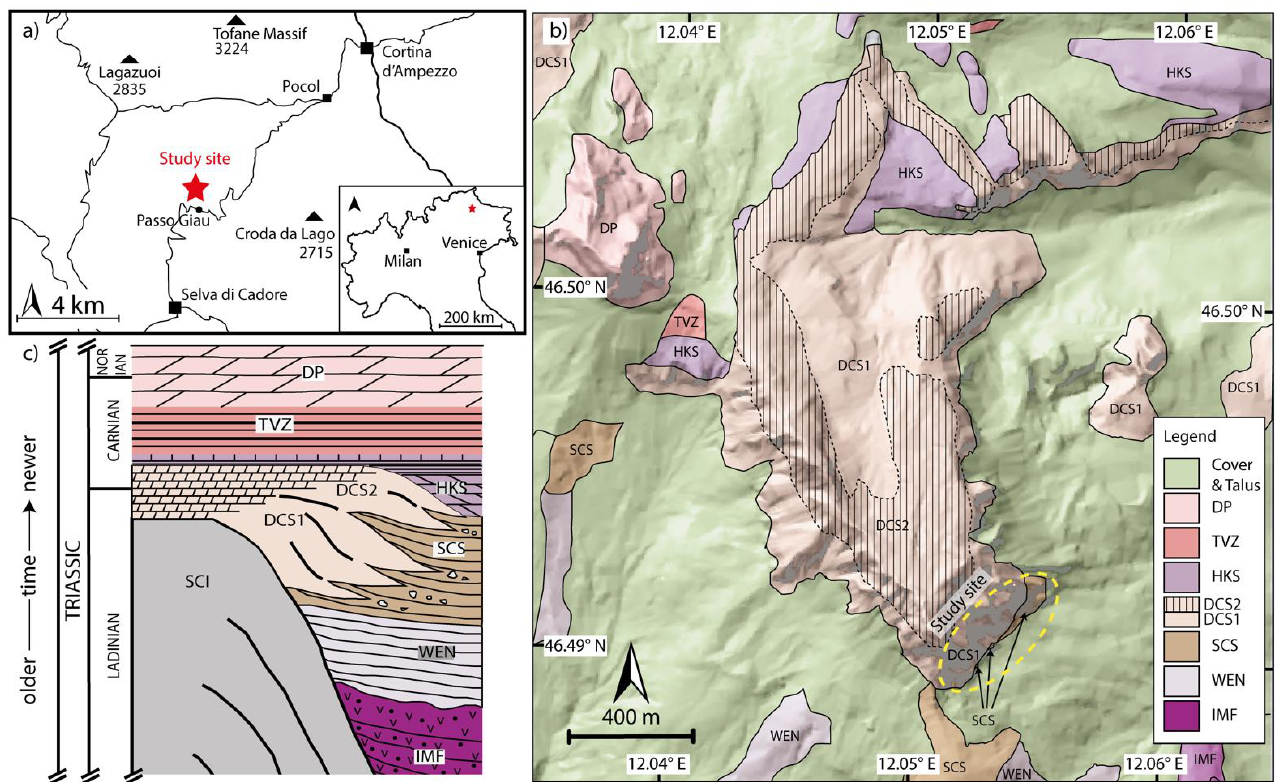
Figure 2. Location map ( a ) of the study site and simplified geological map of the surrounding area ( b ; cf. [27]). The Gusela del Nuvolau outcrop is indicated by the yellow dashed oval. This exposes Middle/Upper Triassic stratigraphy ( c ) of the central-eastern Italian Dolomites [26]: DP, Dolomia Principale; TVZ, Travenanzes Formation (Fm.); HKS, Heiligkreutz Fm.; DCS, Cassian Dolomite Fm.; SCS, San Cassiano Fm.; WEN, Wengen Fm.; SCI, Sciliar Fm.; IMF, Mt. Fernazza Fm.